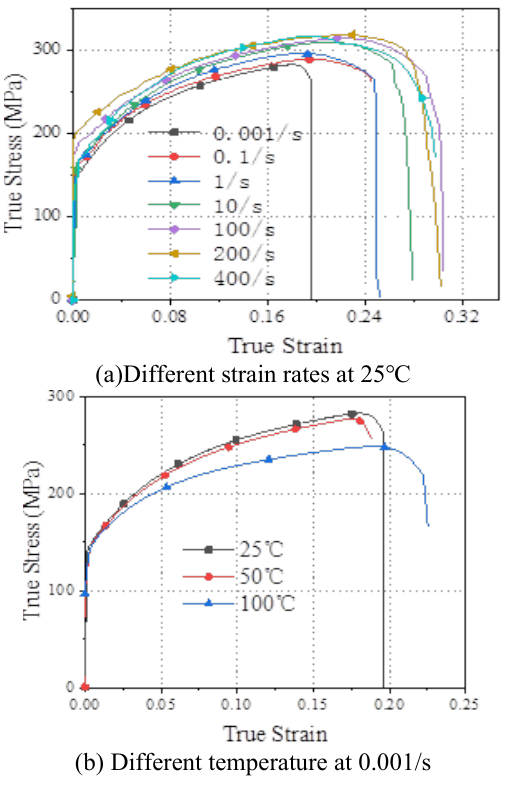
Figure 4. True stress-strain curve for 6008-T6.